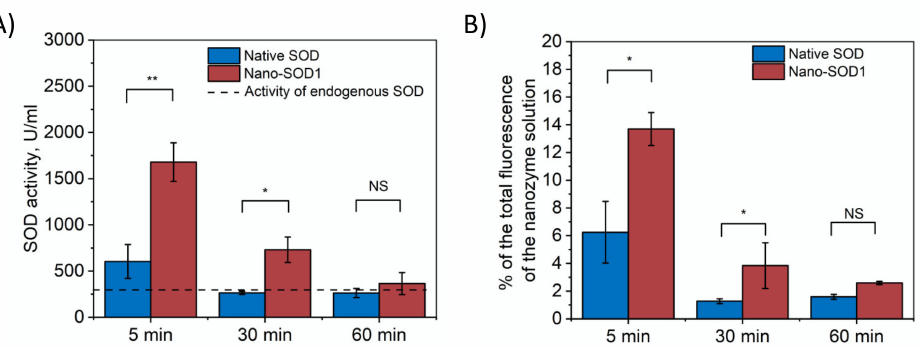
Figure 3. Dynamics of SOD1 and Nano-SOD1 in tears after instillation: ( A ) SOD1 activity; ( B ) SOD1 concentration (percentage of labeled SOD1 fluorescence relative to the initial protein fluorescence). The dashed line corresponds to the activity of endogenous SOD in tears. Symbols indicate the significance levels of differences according to the Mann–Whitney U-test: ** p < 0.01; * p < 0.05; NS—no difference.